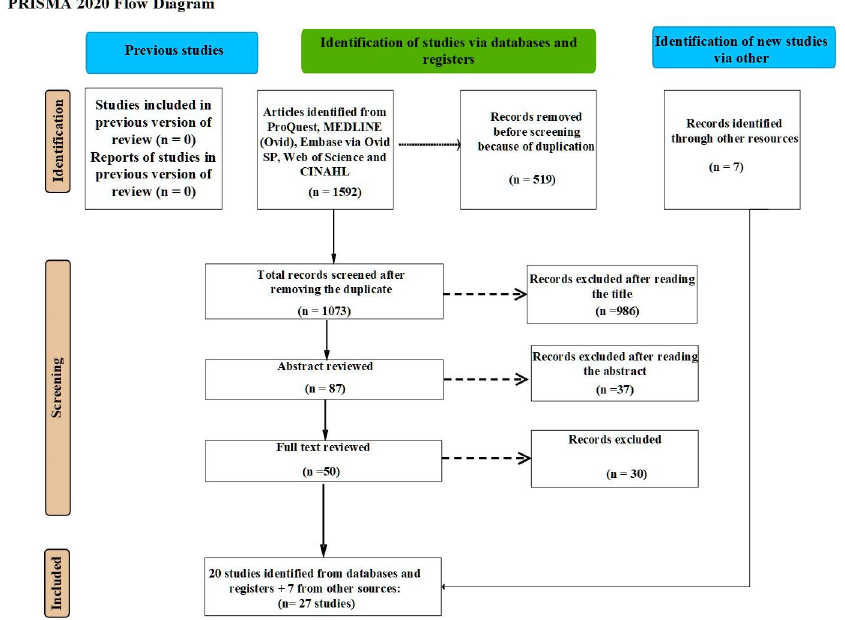
Fig 1. Flow chart of the study selection process based on PRISMA 2020.